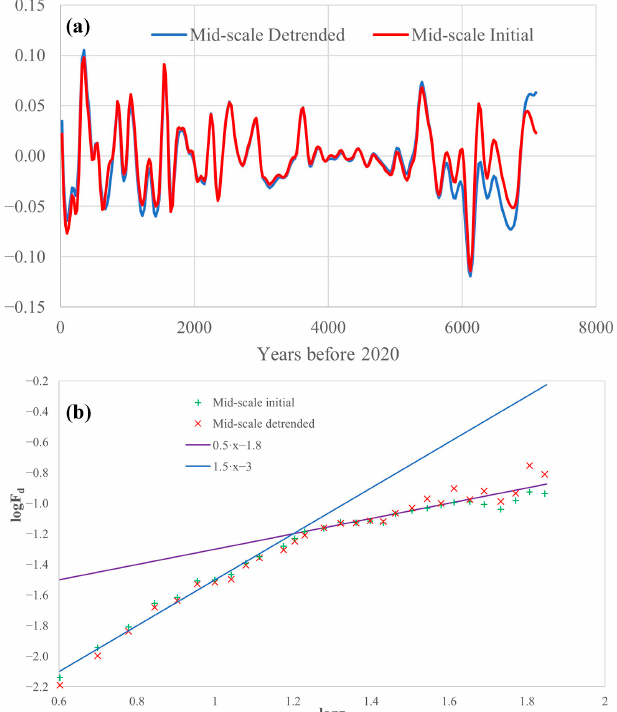
Figure 9. ( a ) Mid-scale IMFs calculated as the sum of IMFs 2, 3 and 4 for the case of mid-scale initial and mid-scale detrended timeseries. ( b ) Hurst analysis. and mid-scale detrended timeseries. ( b ) DFA analysis for the mid-scale components of the initial humification timeseries and the detrended humification